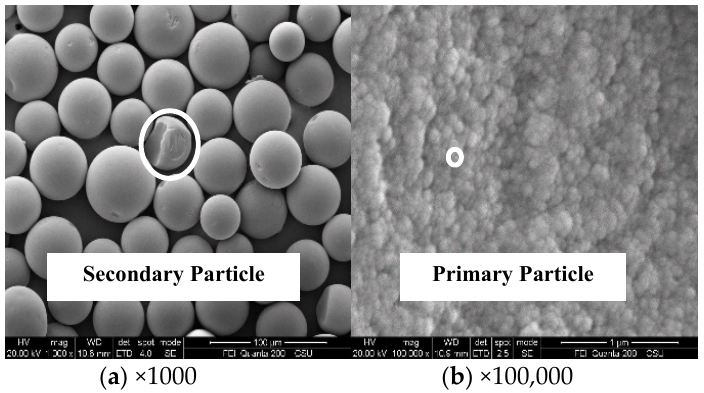
Figure 2. Pore structure of hydrophobic silica nanochannels.